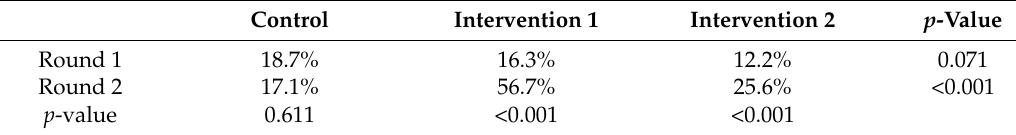
Table 4. DDI-related performance by intervention arm and round: Diagnosis of DDI.